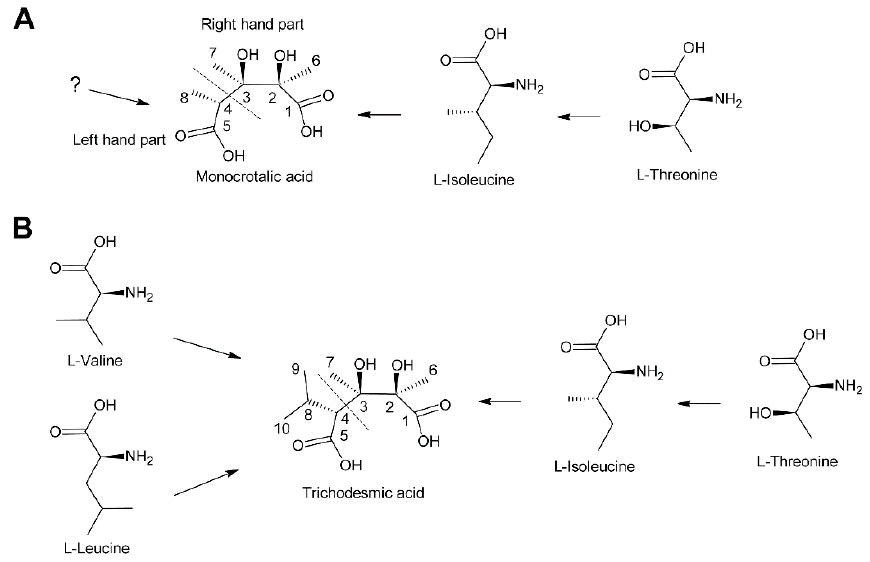
Figure 13. Biosynthesis of necic acids forming 11-membered rings. ( A ) The right hand part of monocrotalic acid is formed from L -leucine (and its precursor L -threonine). The C 3 left hand unit is of unknown origin. ( B ) The right hand side of trachelanthic acid is derived from L -leucine (and its precursor L -threonine) while the left hand side seems to be formed from L -valine or L -leucine. Dotted lines indicate the both sides. Adapted from Reference [70].